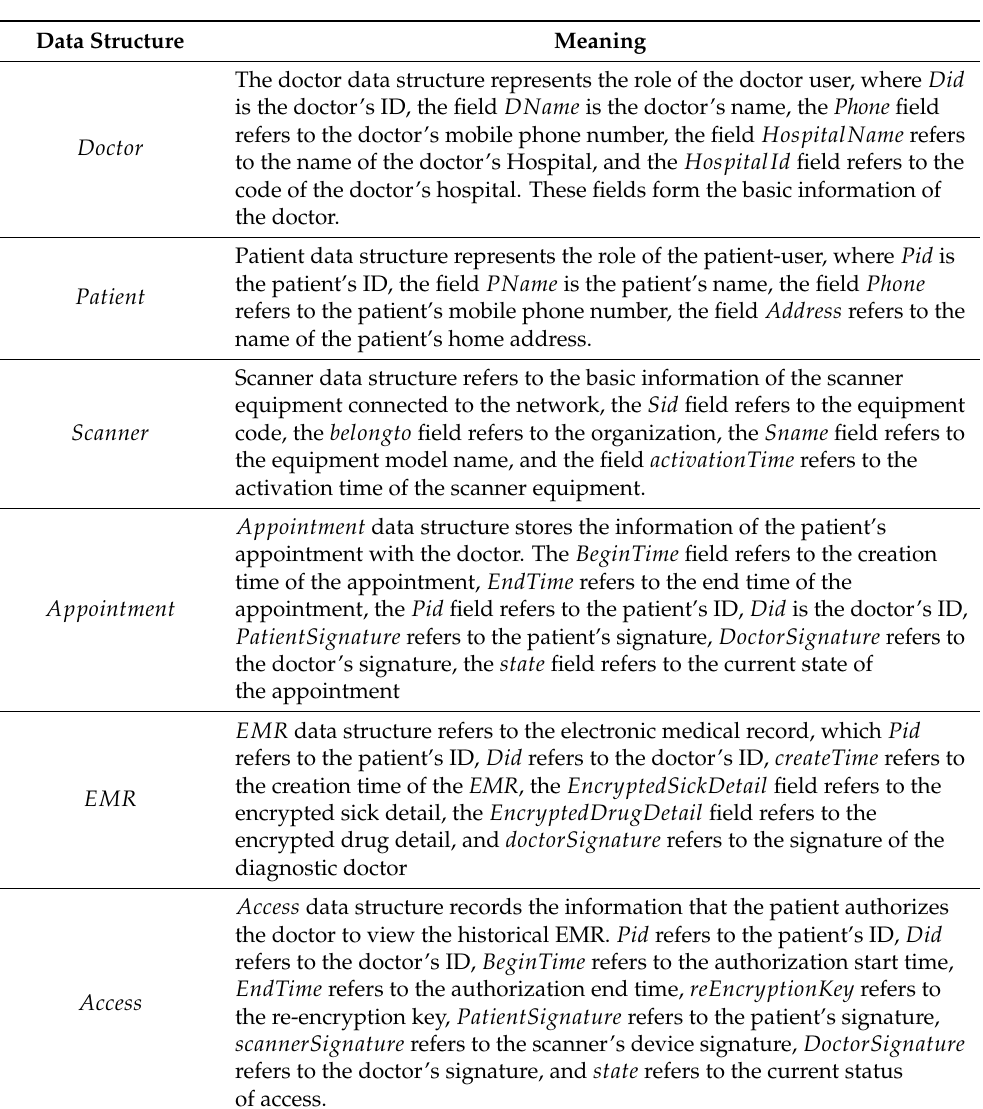
Table 1. Data Structure in